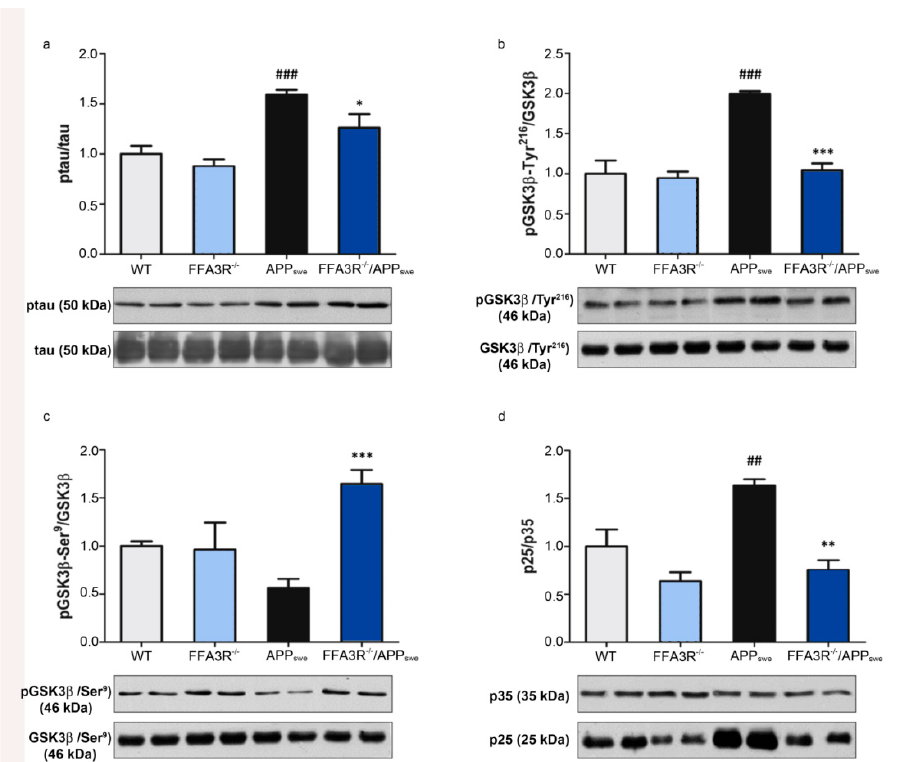
Figure 5. The FFA3R − / − /APP swe mice show improved tau pathology. The levels of different proteins involved in tau pathology were analyzed in total hippocampal protein extracts of WT, FFA3R − / − , APP swe , and FFA3R − / − /APP swe mice by Western blot. We show a representative blot and the quantification of immunoreactive bands for each protein normalized to the ratio of WT mice. The results are expressed as the mean ± SEM (n = 6). Bars represent ( a ) the ratio of ptau vs. tau, ( b ) the ratio of pGSK3 β (Tyr 216 ) vs. GSK3 β , ( c ) the ratio of pGSK3 β (Ser 9 ) vs. GSK3 β , and ( d ) the ratio of p25 vs. p35. ## p < 0.01 and ### p < 0.001 vs. WT. * p < 0.05, ** p < 0.01, *** p < 0.001 vs. APP swe